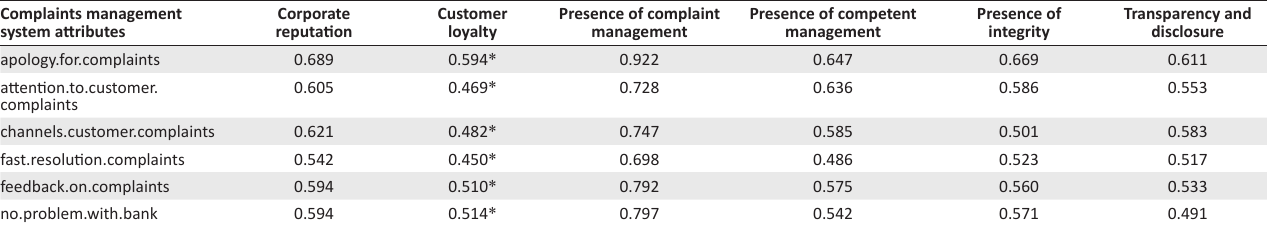
TABLE 6: Cross-loadings (correlations) of complaint management system attributes on customer